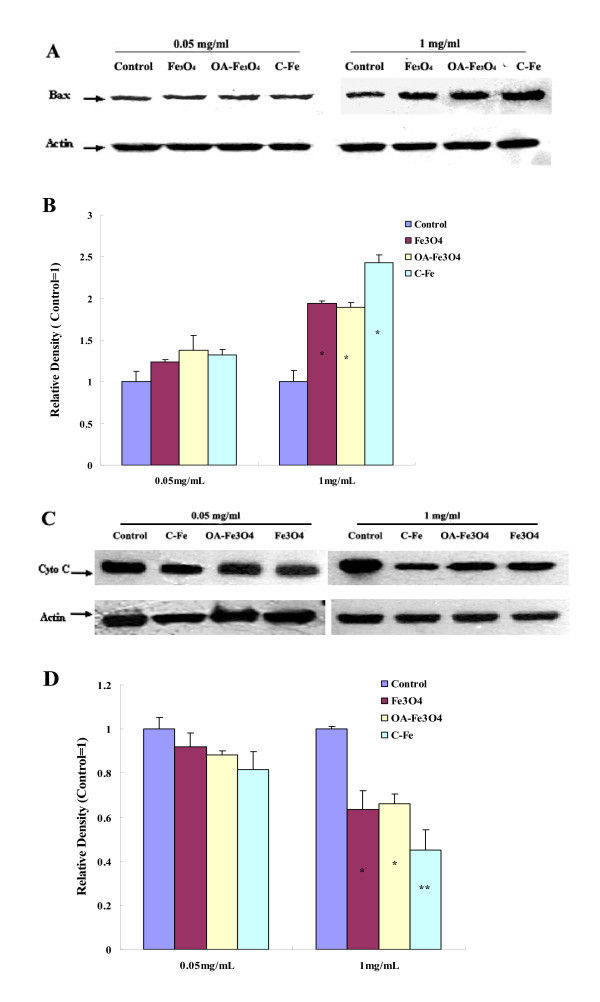
MNPs induced Bax over-expression and Cytochrome C release. Up-regulation of Bax expression in BEL-7402 cells treated with MNPs (A) and plotted as a relative level (B); down-regulation of cytochrome C expression in BEL-7402 cells treated with MNPs (C) and plotted as a relative level (D) *P < 0.05 vs. control; **P < 0.01 vs. control.